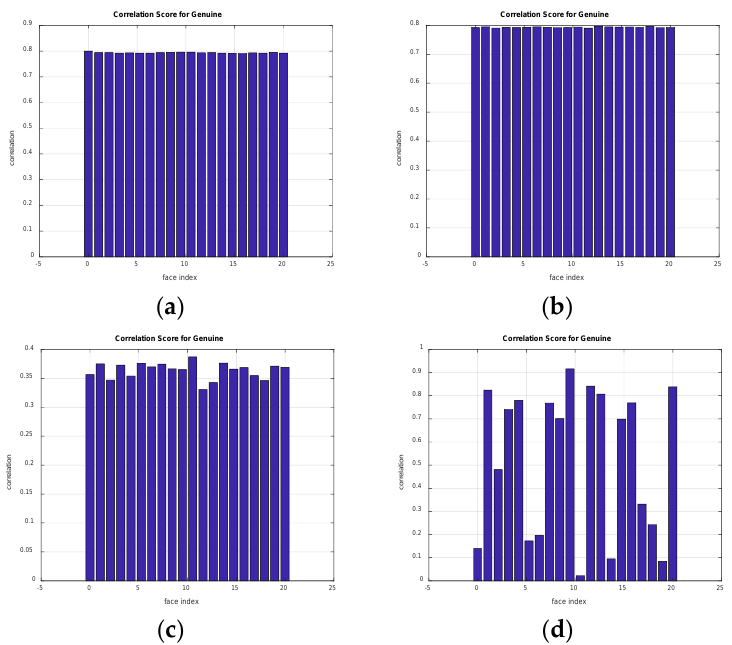
random kernel convolution.